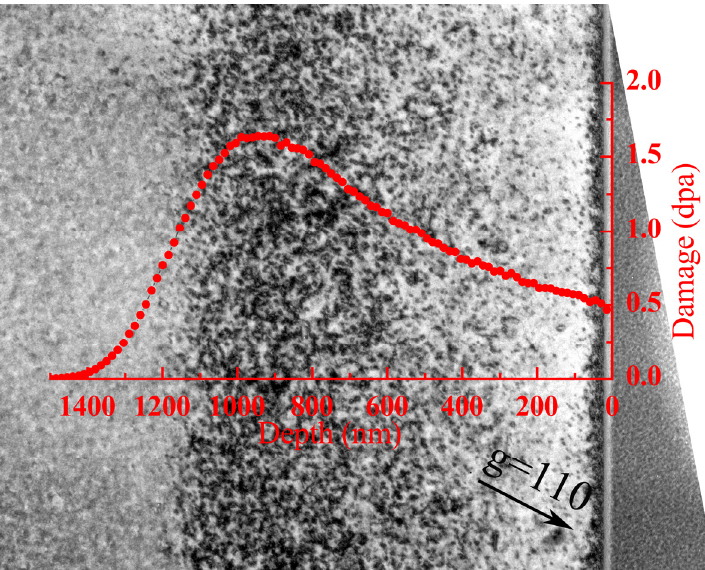
Figure 2. Bright field TEM micrographs of FeCrAl alloy under the condition of [001] pole, 𝒈 = − 110, and the displacement damage distribution calculated by SRIM irradiated by 3.2 MeV Fe 13+ ion with the fluence of 1.9 × 10 15 cm − 2 .